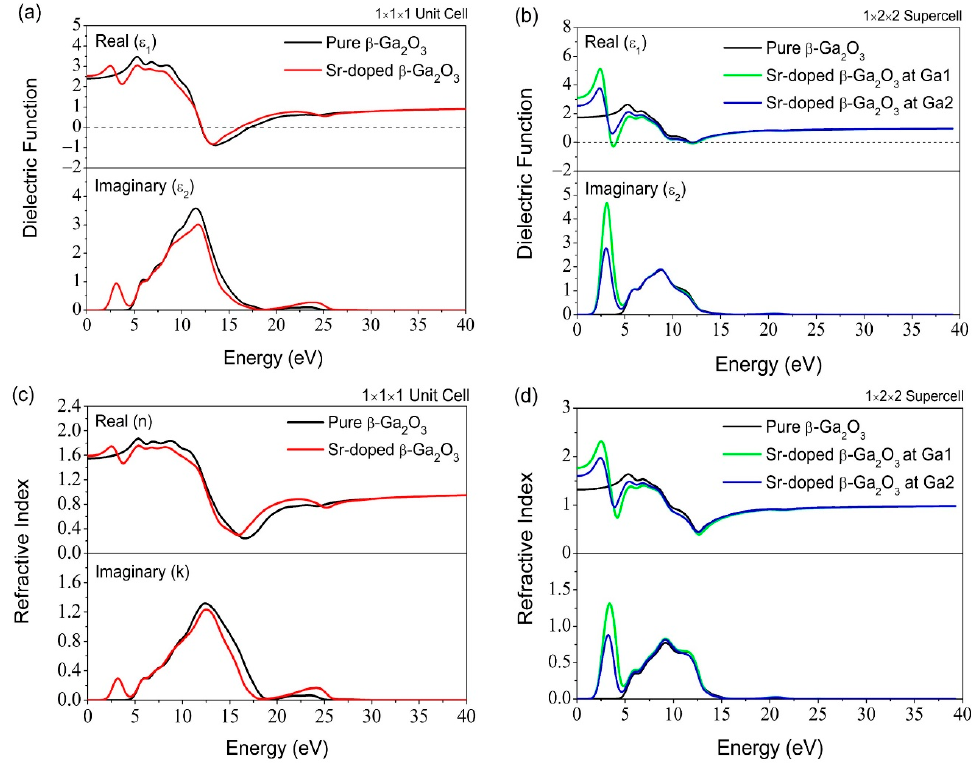
Figure 12. ( a ) Dielectric Function 1 × 1 × 1 unit cell, ( b ) Dielectric Function 1 × 2 × 2 supercell, ( c ) Refractive Index 1 × 1 × 1 unit cell, ( d ) Refractive Index 1 × 2 × 2 supercell.